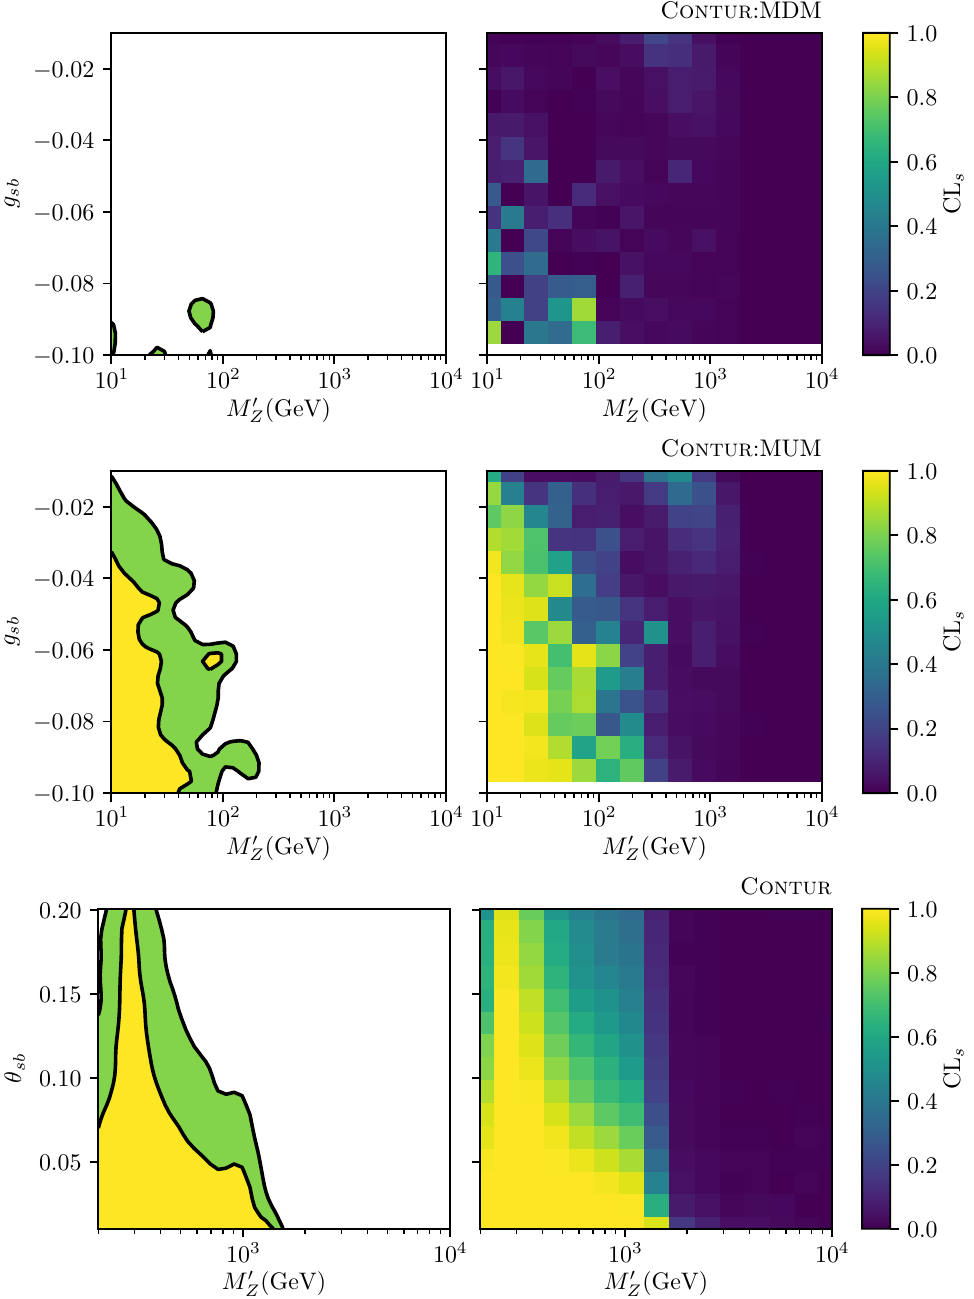
Figure 5 . Contur constraints on the MDM model (top), the MUM model (middle) and the TFHMeg (bottom). In the left-hand panels, we show regions excluded at the 68% and 95% CL levels. In the right-hand panels, we show the CL Everywhere throughout the parameter plane shown, the NCBAs are fit by fixing g eqs. (2.2), 2.16, respectively, for x = 1 .